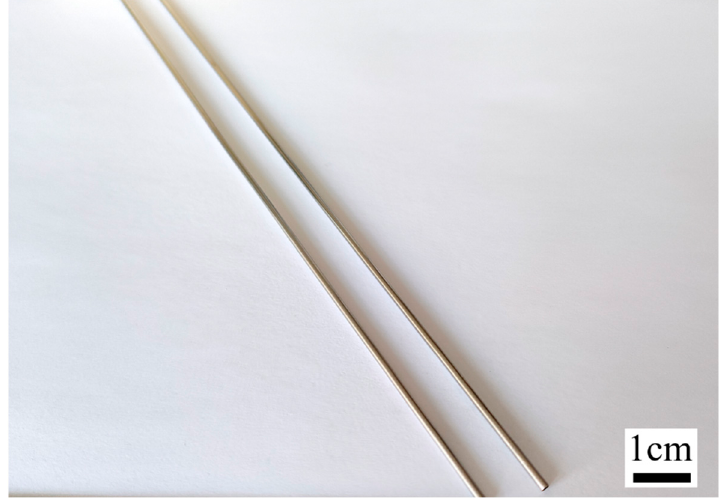
Figure 4. Ultraslender nickel–titanium alloy cardiovascular stents tube. Table 2. The chemical constituents of Ni-Ti alloy cardiovascular stent tube.